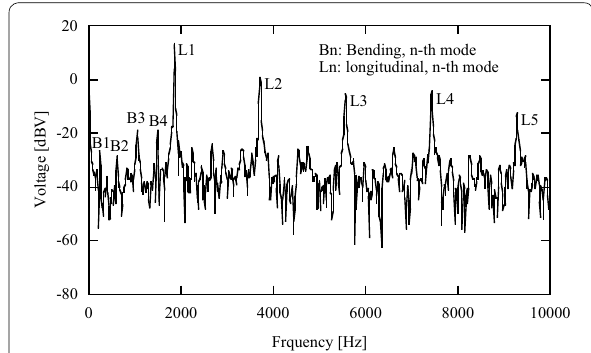
Fig. 4 An example of waveforms of vibration test, where the specimen is suspended by two threads